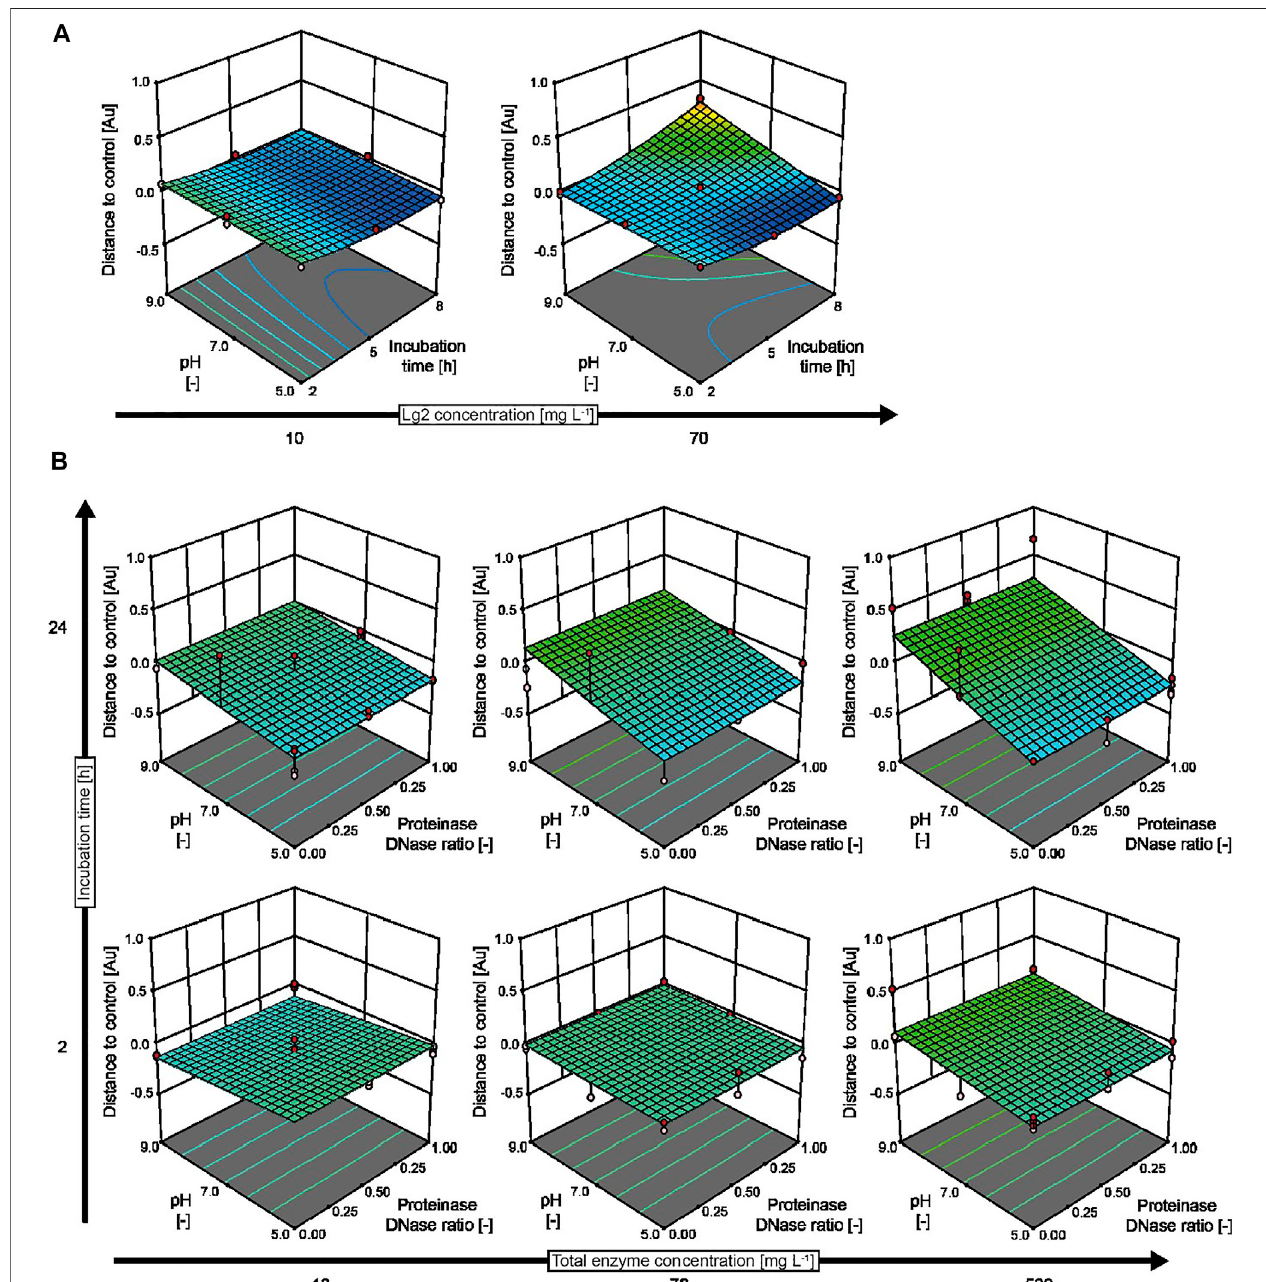
FIGURE 3 | Response surface models predicting the effect of bio fi lm-degrading enzymes. (A) The effect of IMAC – puri fi ed Lg2 compared to authentic controls prepared for each oftheconditionstested inan I-optimal responsesurfacedeignwith 24runs. (B) Combined action ofproteinase K and DNase Itreatmenton wild-type B.subtilis bio fi lmsbasedonaD-optimalcombined mixturedesignwith153runsconductedinthreeblocks.Theexperimental designscoveredpHvaluesintherangeof 5.0 – 9.0, enzyme concentrations in the range of 10 – 70 mg L − 1 (Lg2) or 10 – 500 mg L − 1 (proteinase K and DNase I), and incubation periods in the range of 2 – 8 h (Lg2) or 2 – 24 h (proteinase K and DNase I). The assay buffer was 50 mM di-sodium hydrogen phosphate, and 100 mM sodium chloride (Lg2) or 50 mM TRIS (pH 7.0 – 9.0)orMES(pH5.0),with5mMcalciumchloride,5mMmagnesiumchloride(proteinaseKandDNaseI).Membraneswithanevaporationrateof544 gm − 2 d − 1 were used for all